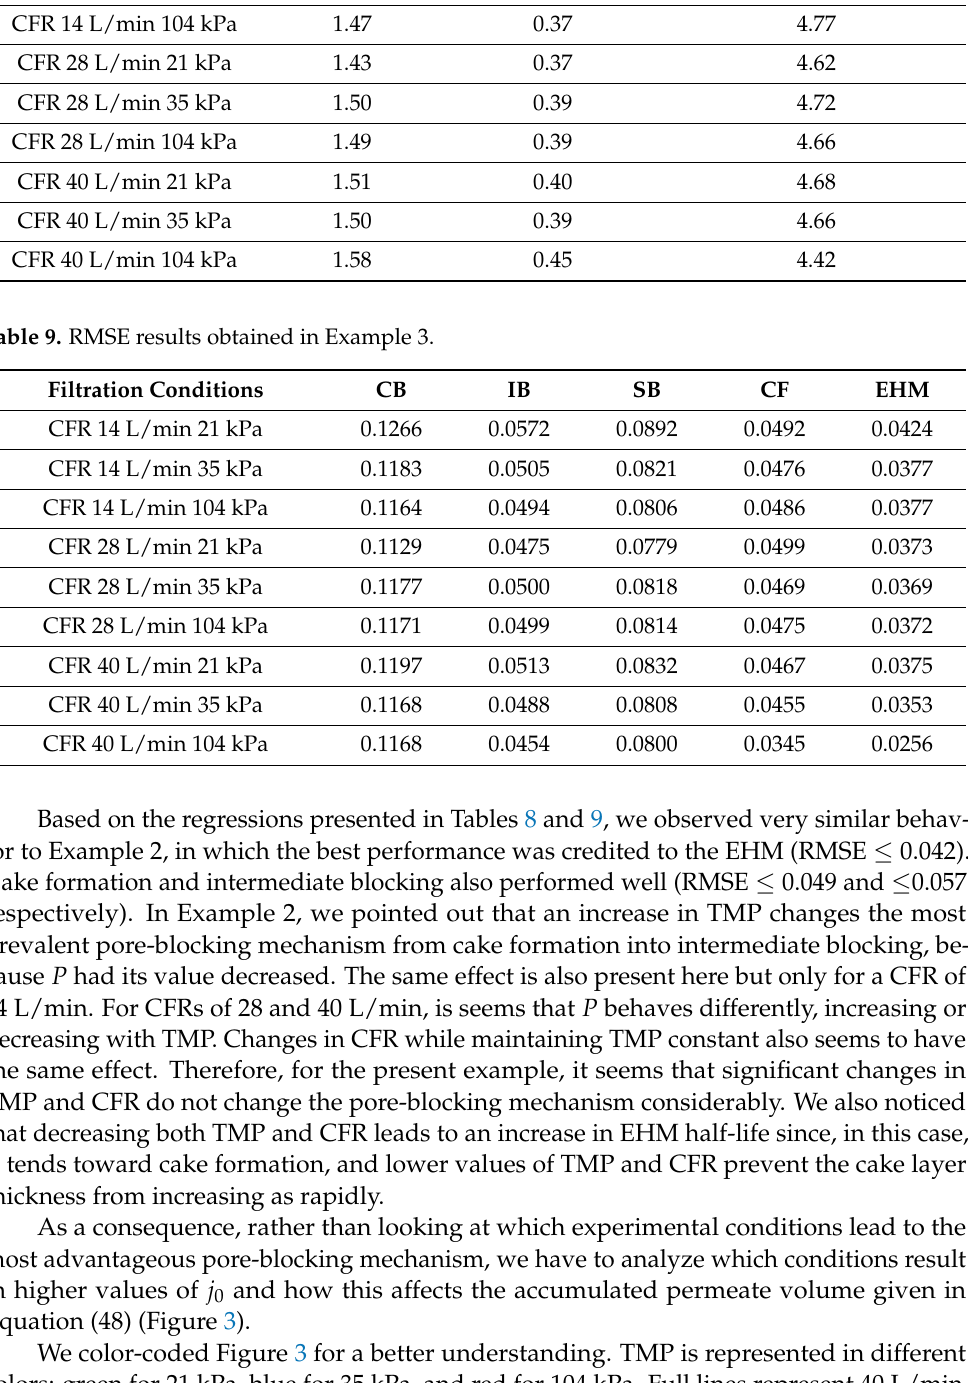
discontinued lines represent 28 L/min, and dotted lines represent 14 L/min.